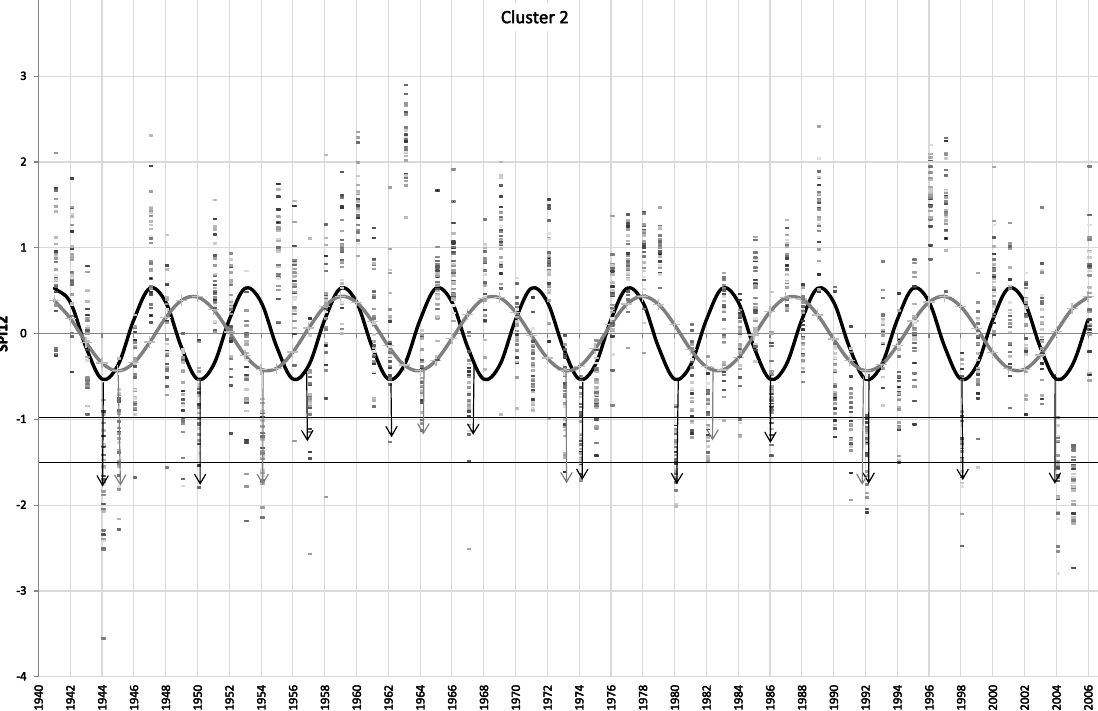
Figure 5. SPI-12 December values for central/southern Portugal (cluster 2) + waves of period 6 (black line) and 9.4years (grey